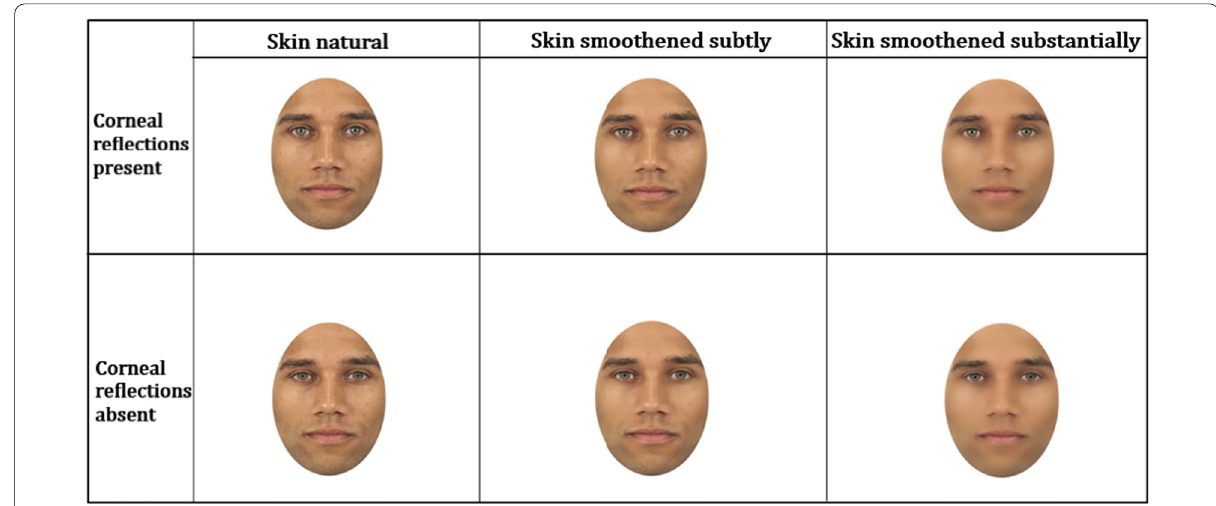
Fig. 3 Example of a face stimulus in all conditions in Experiment 2. The top row shows different levels of skin contrast: the face with the smoothest skin (right), the face with skin that is the least smooth (left), and the face whose skin is in-between regarding smoothness (middle) when corneal reflections are present. The bottom row shows each face with differing skin appearance when corneal reflections are